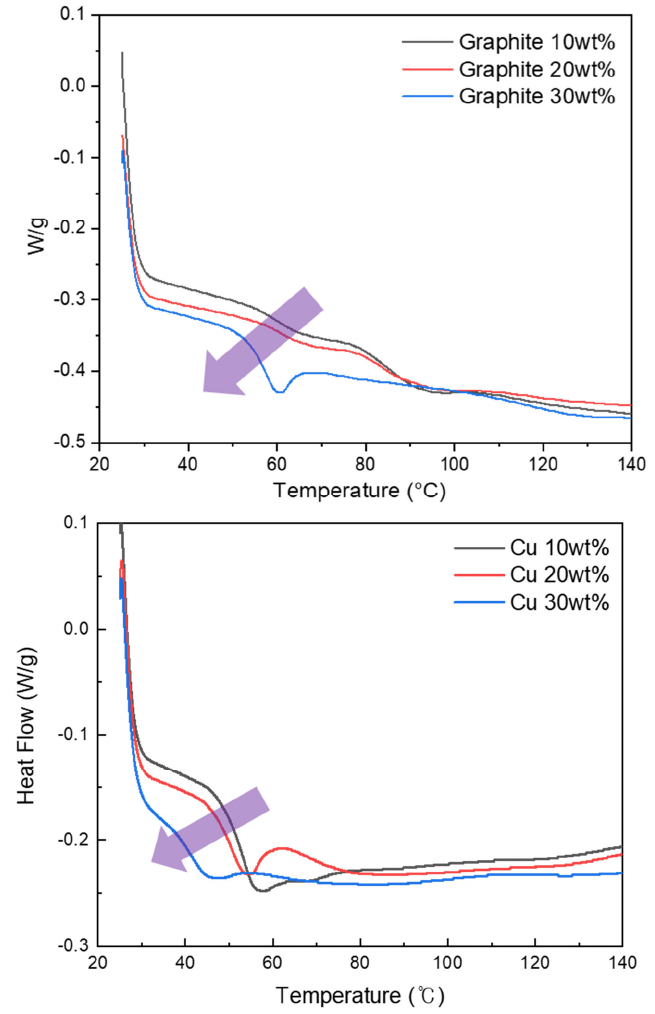
Figure 6. Results of DSC according to filler type and amount with Epoxy 10/1.